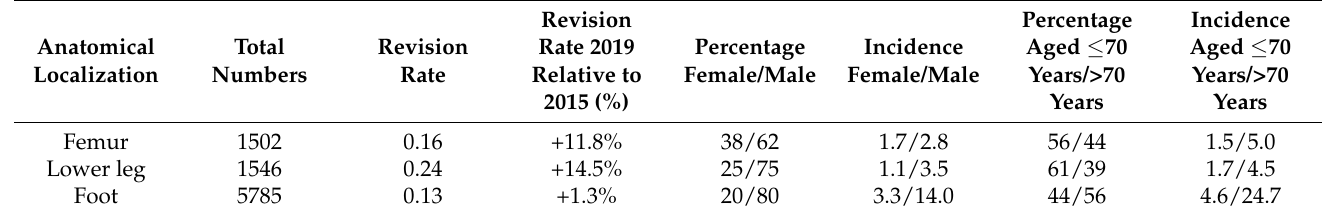
Table 4. Incidence rates of revision amputation procedures performed in the year 2019 divided by anatomical